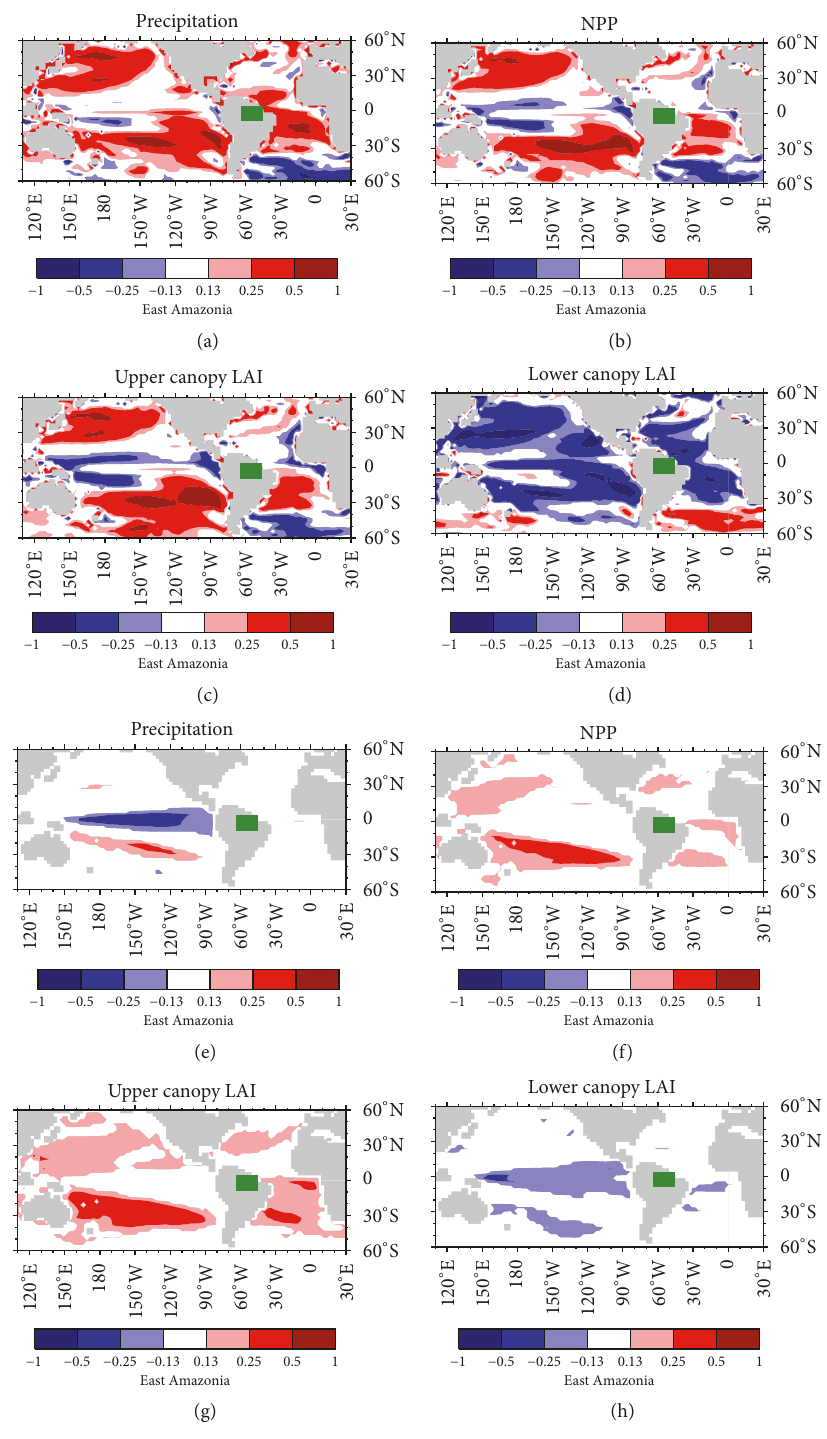
Figure 7: Same as Figure 5 but for EA